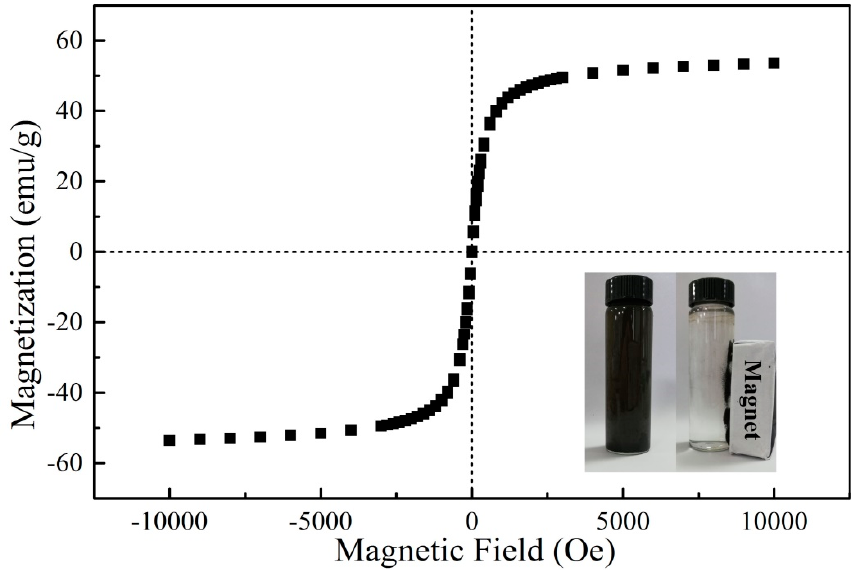
Figure 2. Magnetization curve of GO / Fe 3 O 4 at room temperature.